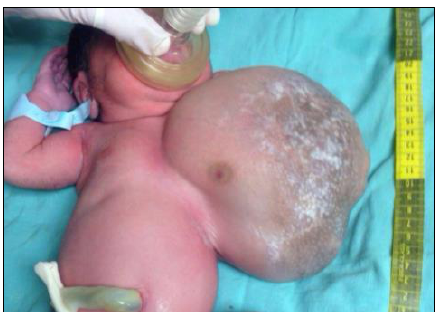
Figure 1: Giant lymphatic malformation.